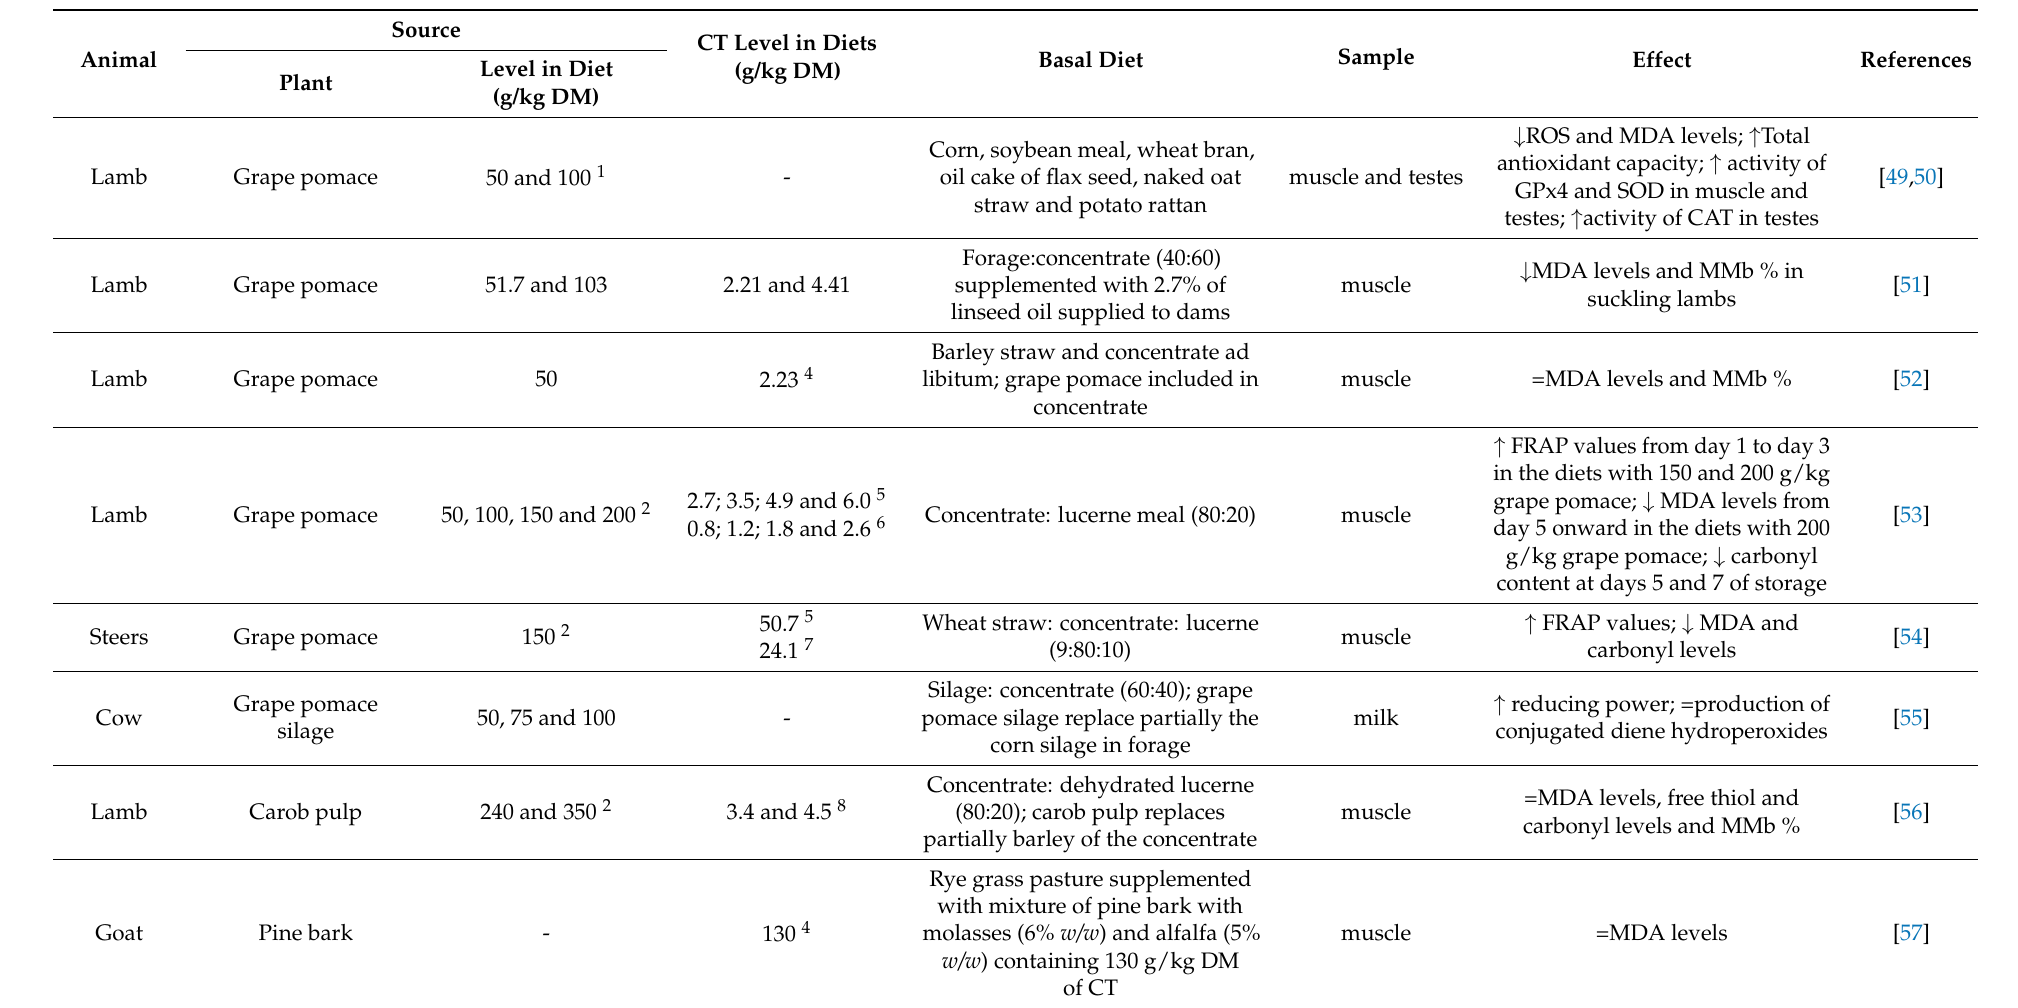
Table 1. Antioxidant effect of utilization of condensed tannin-rich plants and agro-industrial by-products in ruminant